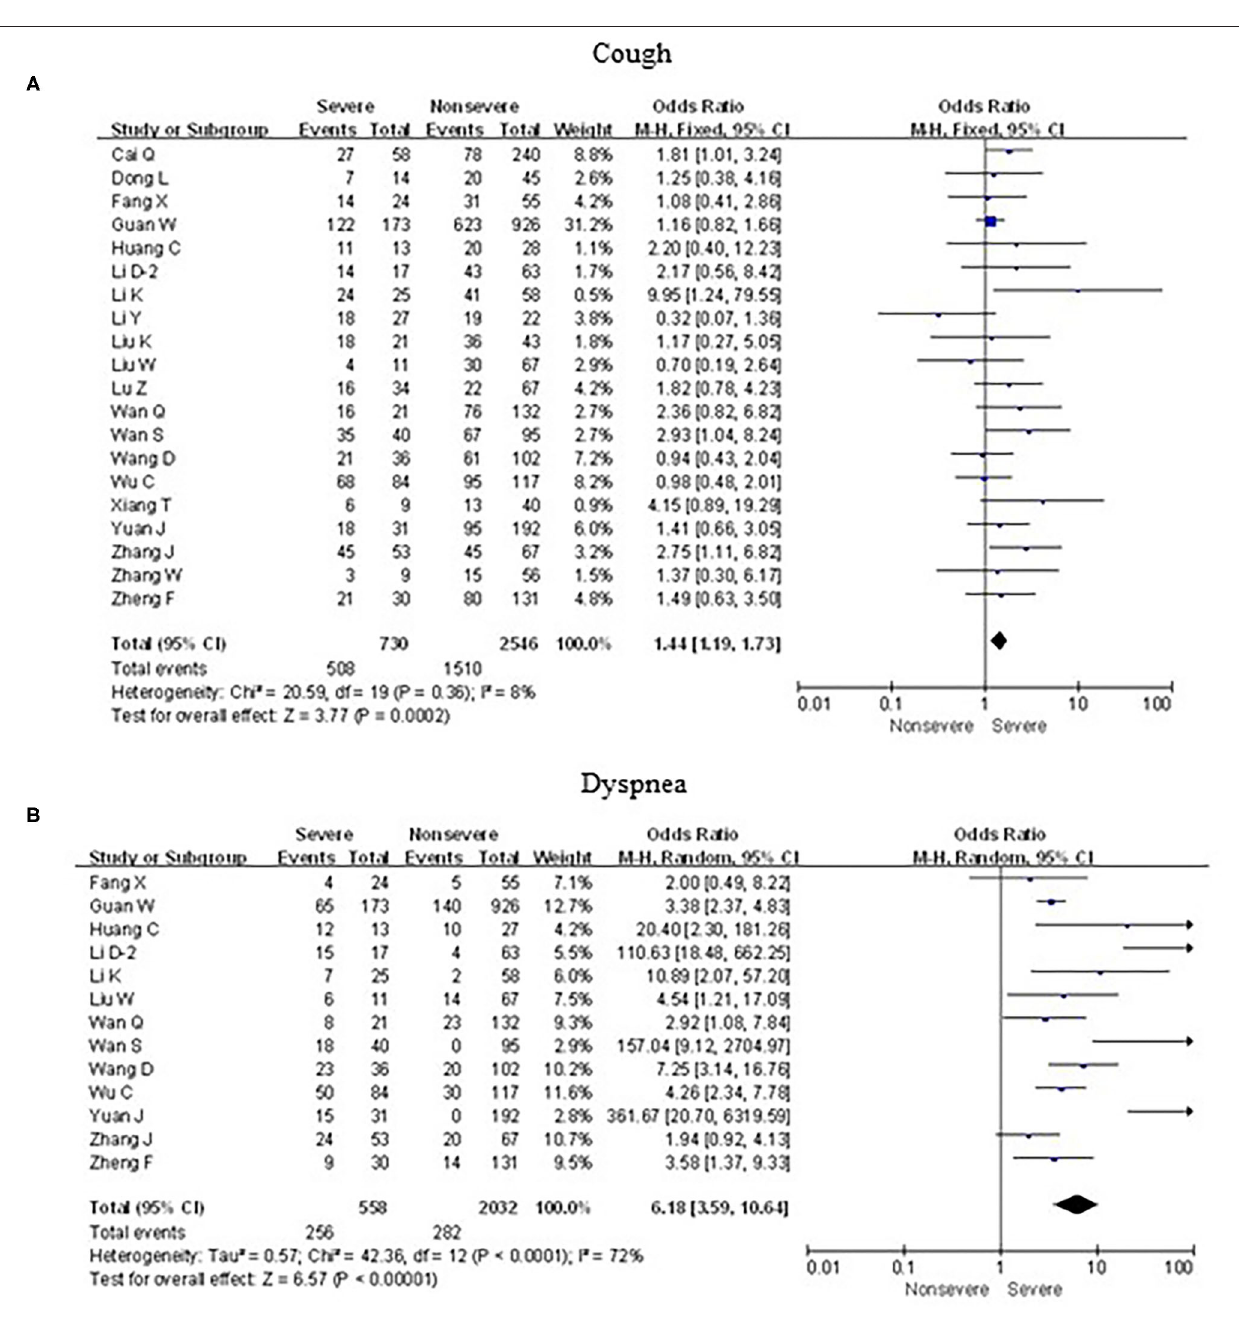
of COVID-19 were fever, cough, and dyspnea (24, 25).